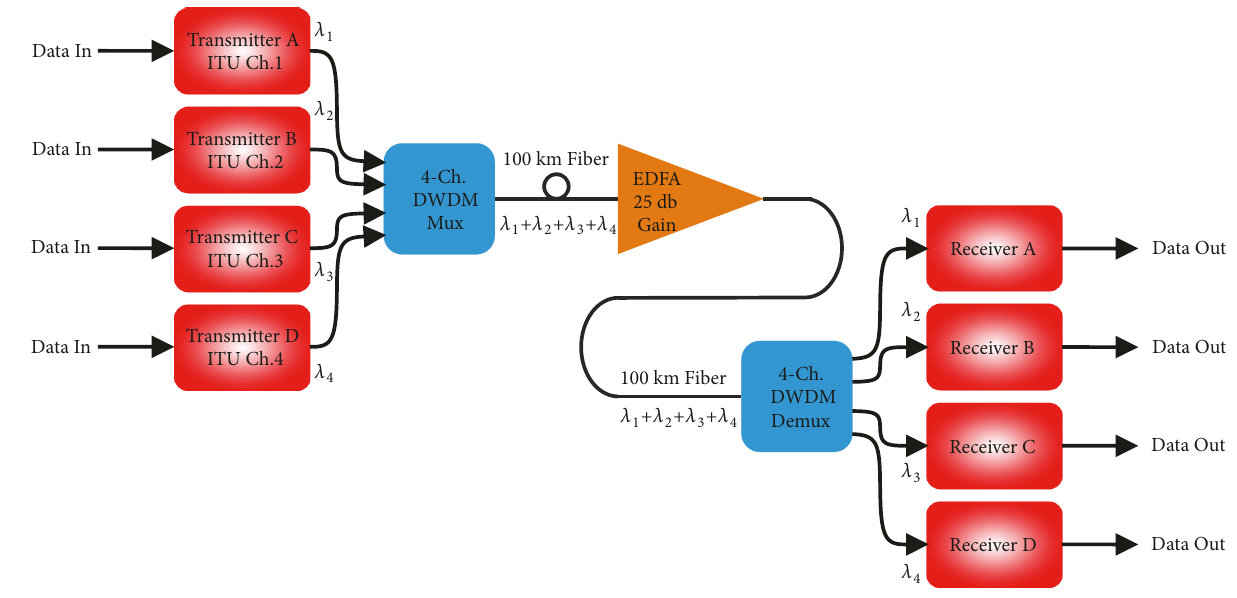
Figure 1: Suggestion for 4-channel DWDM